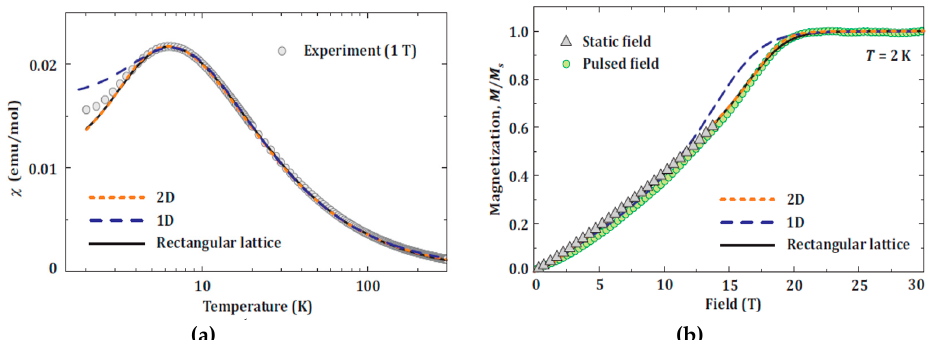
Figure 5. ( a ) Fits of the magnetic susceptibility of Cu(PM)(EA) 2 with the model (Equation (4)) for R = 0 (1D) with J / k B = 10.2 K, g = 2; R = 1 (2D) with J / k B = 6.8 K, g = 2.05; R = 0.7 (rectangular lattice) with J / k B = 8.0 K, g = 2.07; ( b ) Field dependence of the magnetization of Cu(PM)(EA) 2 . Lines show the simulations with the same parameters as those used for the susceptibility. (Reproduced with permission from reference